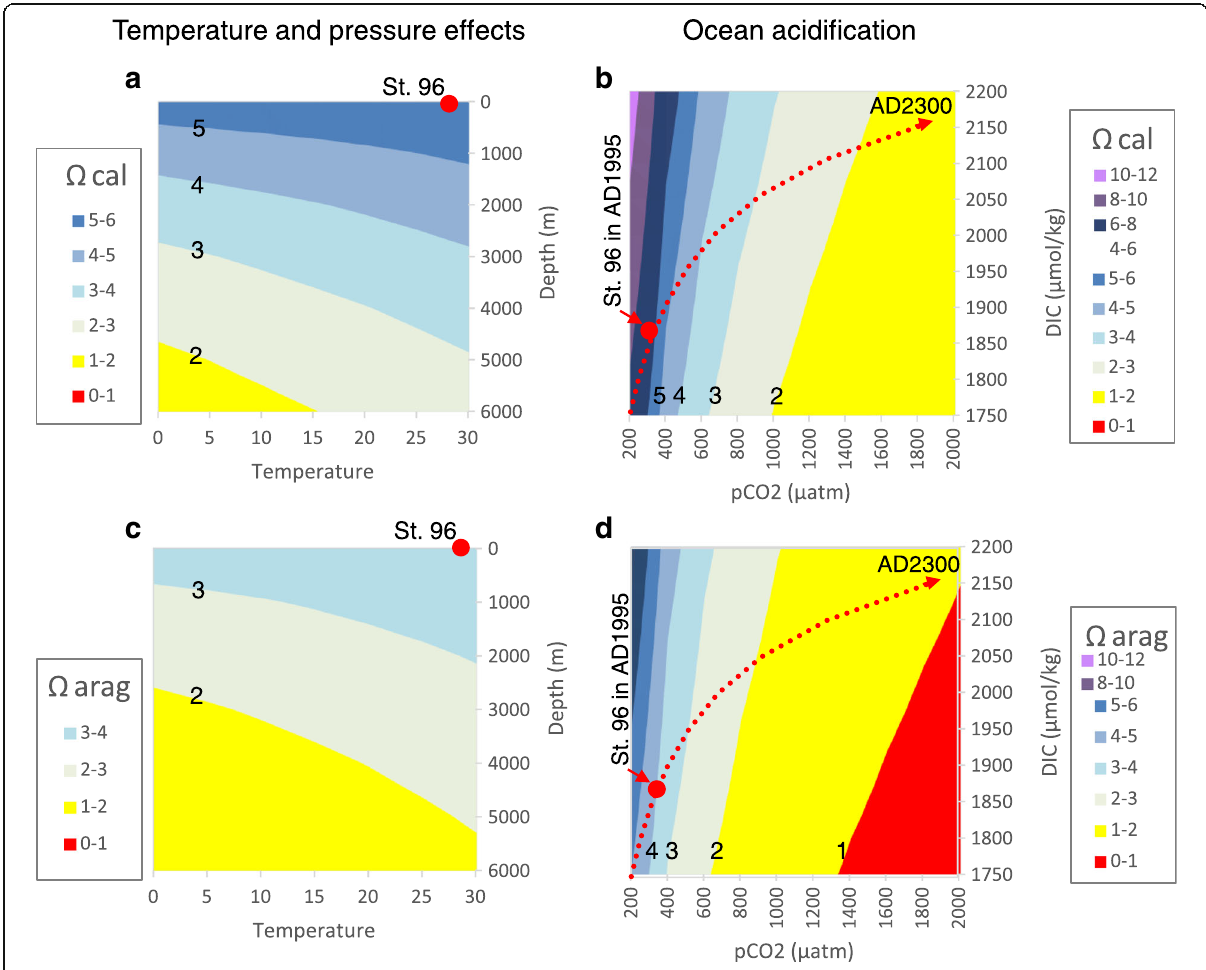
Fig. 5 Carbonate saturation state of seawater ( Ω cal and Ω arag ) influenced by changes in physical condition ( a , c ) and ongoing ocean acidification ( b , d ). The surface seawater compositions in the tropical western Pacific were used as an example (St. 96 of NOPACCS NH95-1 cruise; 5° 00 ′ N, 144° 55.7 ′ E; water depth 4102 m; sampling date April 22, 1995; data available from http://pacifica.pices.jp/table/). The red dotted lines in panels b and d represent the possible future trajectory of seawater compositions, as influenced by ocean acidification (Caldeira and Wickett 2003). The chemical equilibrium calculation was conducted using CO2calc (Robbins et al. 2010). Note that the CO 2 system change in seawater caused by ocean acidification is much more significant to the carbonate saturation state of seawater, as compared with physical condition changes including temperature and